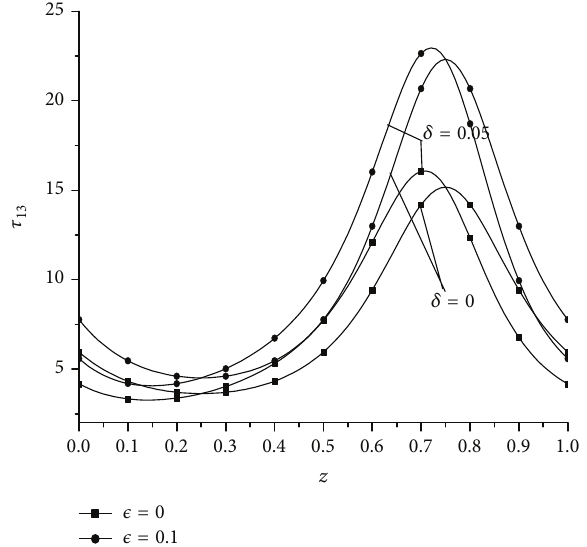
Figure 13: Wall shear stress 𝜏 13 at the outer wall versus 𝑧 with different values of 𝛿 and 𝜖 at Wi = 0.01 , 𝑄 = 1.5 , 𝜙 = 0.4 , and Re = 10 .